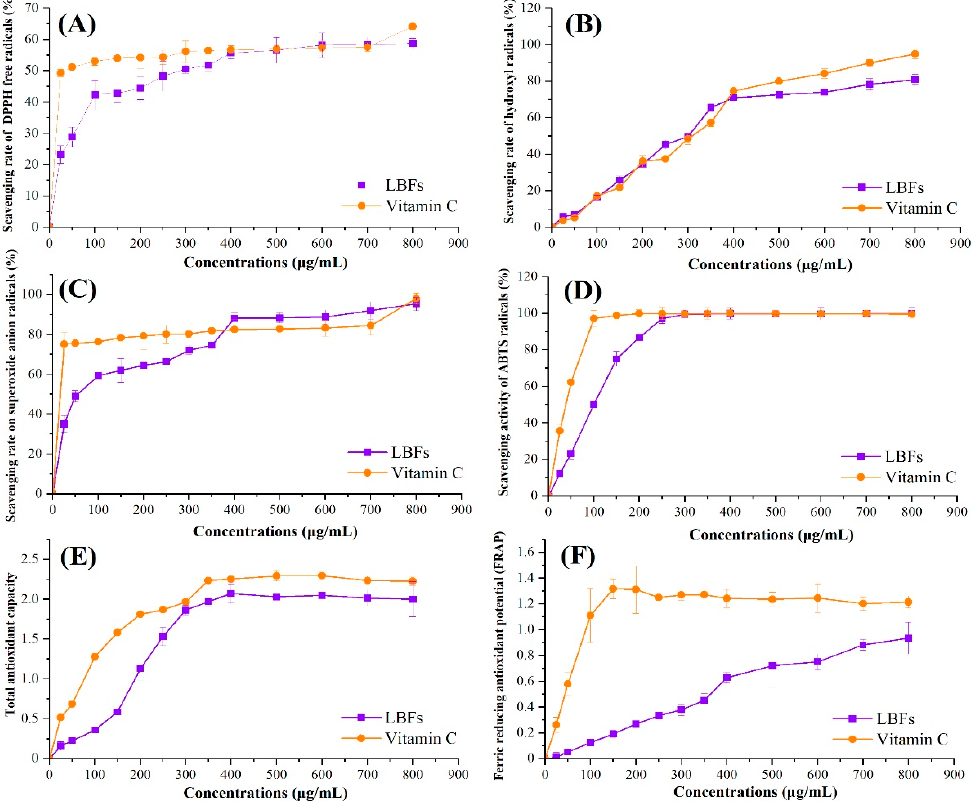
Figure 3. Comparison of antioxidant activities of the extract of flavonoids from the fruits of Lycium barbarum and V C determined by DPPH free radical-scavenging assay ( A ), hydroxyl radical- scavenging assay ( B ), superoxide radical-scavenging assay ( C ), ABTS radical-scavenging assay ( D ), total reducing capacity (TRC) assay ( E ), and FRAP assay ( F ). The concentrations of sample solution were 25, 50, 100, 150, 200, 250, 300, 350, 400, 500, 600, 700, and 800 μ g/mL in the proper order. Each value was expressed as means ± S.D. ( n = 3).